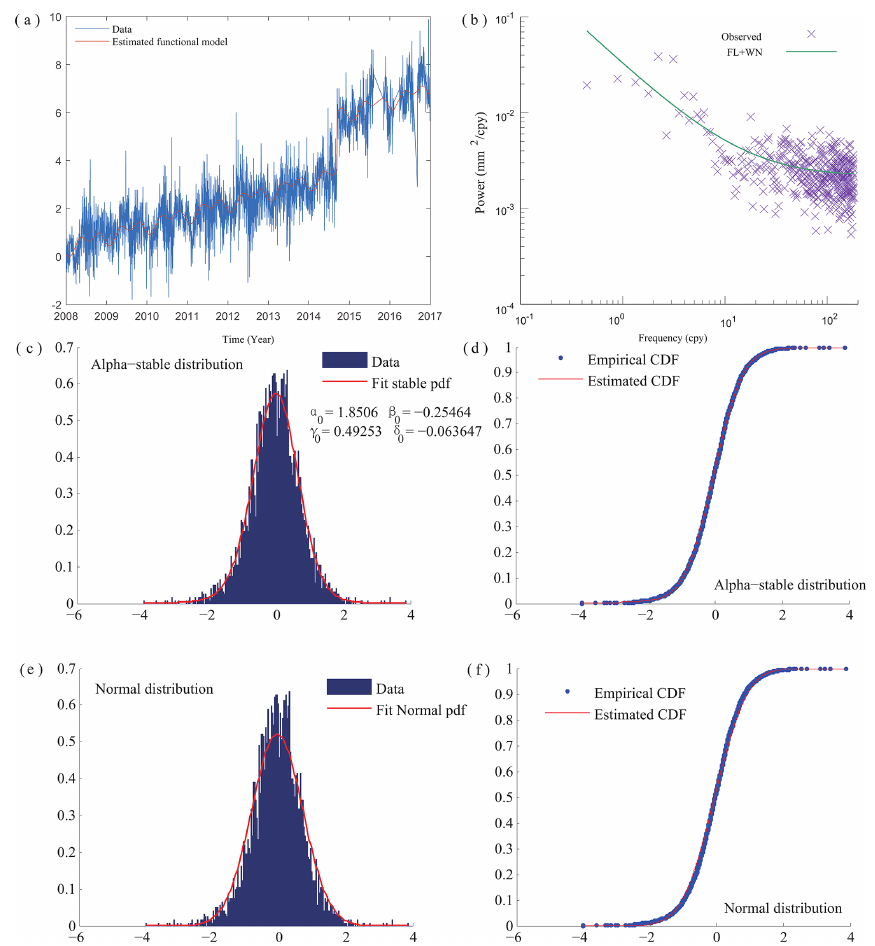
Figure 3. GNSS time series for the ASCO station (eastern coordinate) with the PL + WN model. (a) The time series together with the functional model, (b) the power-spectrum, (c) residual time series with Lévy α –stable distribution, (d) cumulative density function residual time series, and Lévy α –stable distribution (Corr. Lévy = 0 . 98). (e) Residual time series with normal distribution and (f) cumulative density function of the residual time series and normal distribution (corr. Norm. = 0 .